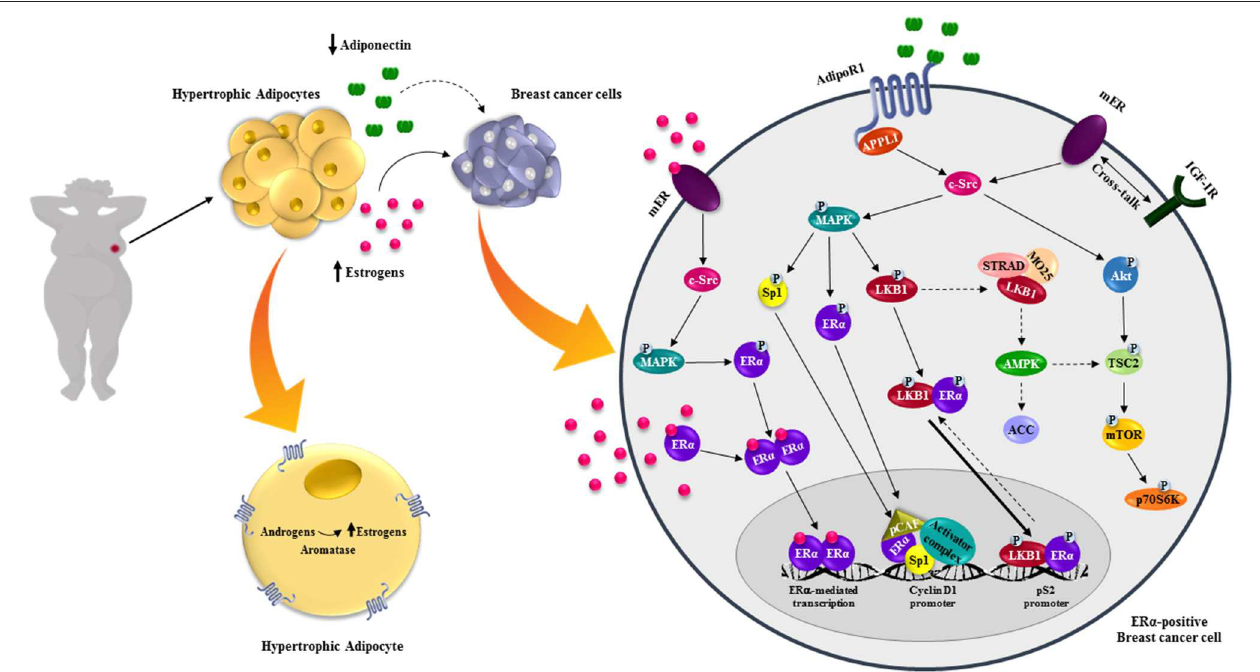
FIGURE 2 | Effects of adiponectin on ER α -positive breast cancer cells. Obesity is characterized by hypertrophic adipocytes, which release high levels of estrogens, due to the increased aromatase activity, and low adiponectin concentrations. Estrogens bind and stimulate estrogen receptors action at both genomic and non-genomic levels. In ER α -positive breast cancer cells low adiponectin levels activate different intracellular signaling pathways promoting breast tumor growth.